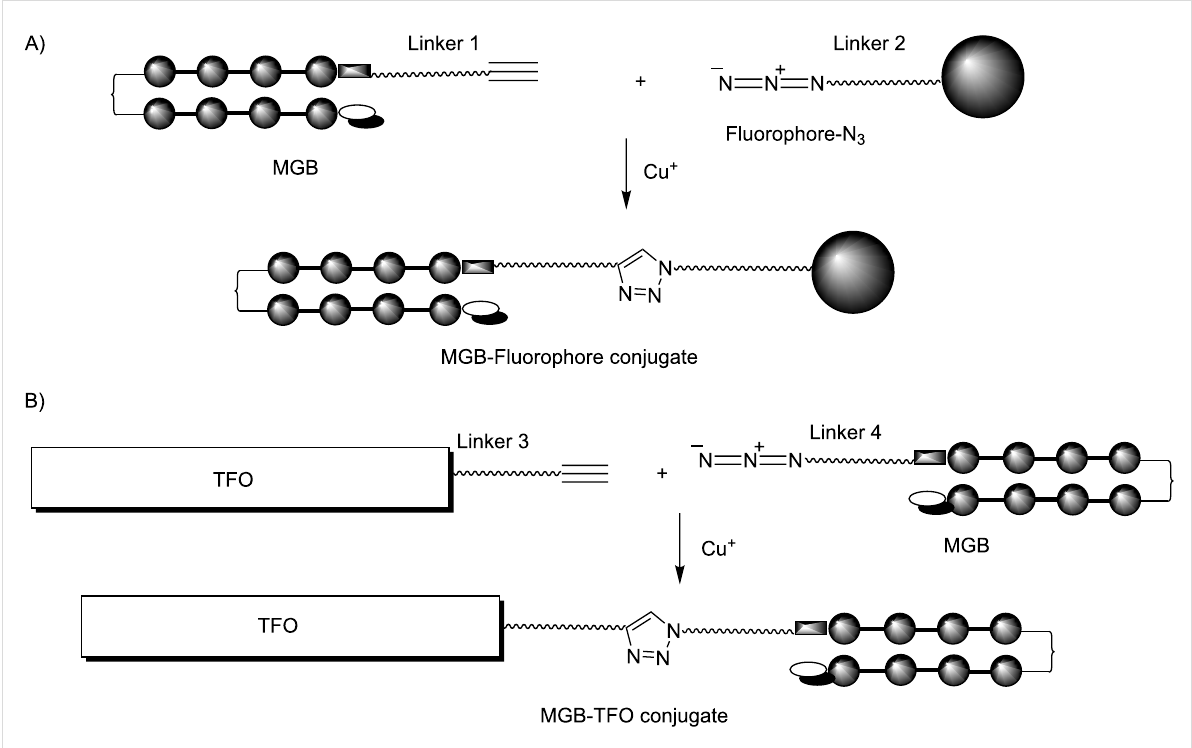
Figure 2: Synthesis of MGB-fluorophore (A) and MGB-TFO (B) conjugates using CuACC. Linker length and composition can be